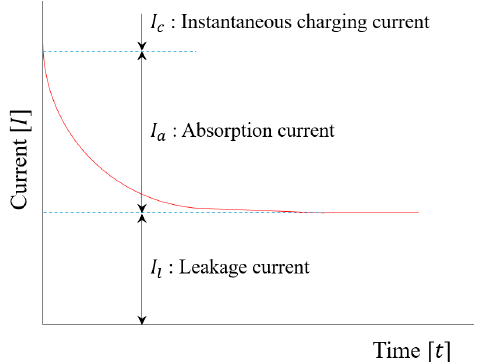
Figure 6. Graph of the current when the DC voltage is applied to the dielectric.